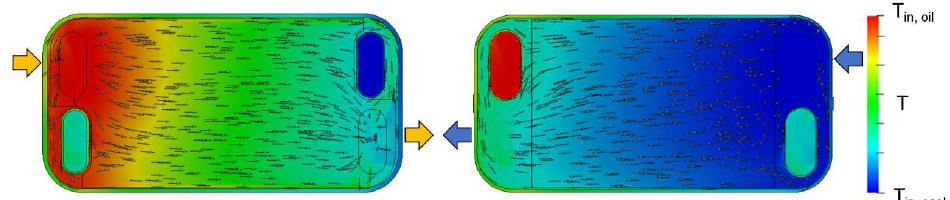
Figure 20. Cooler B: Temperature distribution across two transversal planes for oil and coolant passages, located in the middle of the heat exchanger. Flow direction is also reported. Operating conditions: Q oil = 50%, Q cool = 80%.